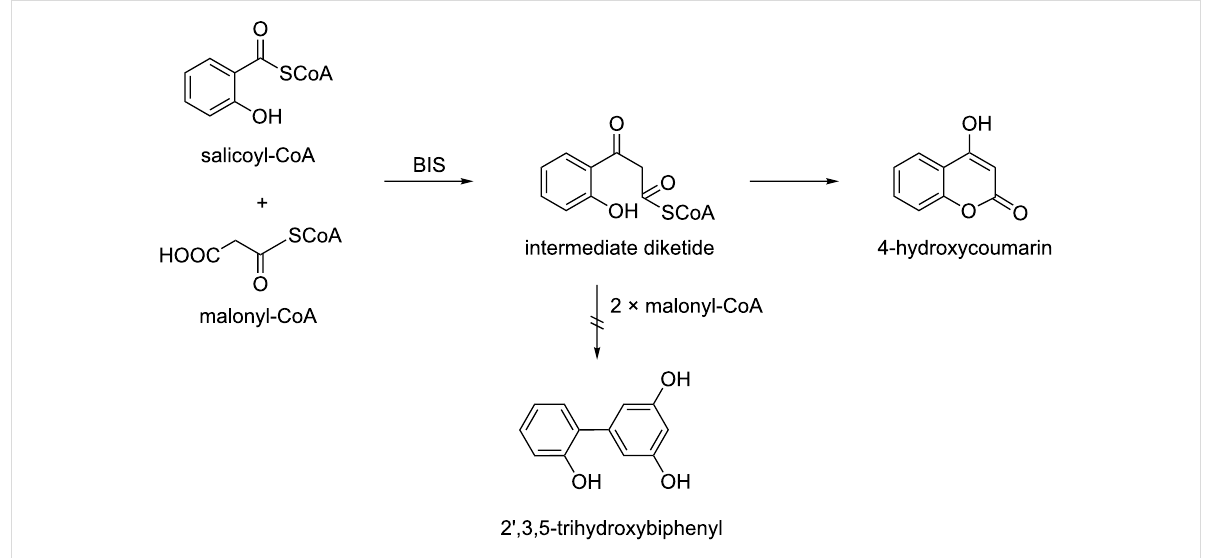
Figure 5: In vitro biosynthesis of 4-hydroxycoumarin by biphenyl synthase (BIS). No formation of 2',3,5-trihydroxybiphenyl was observed [35,36].